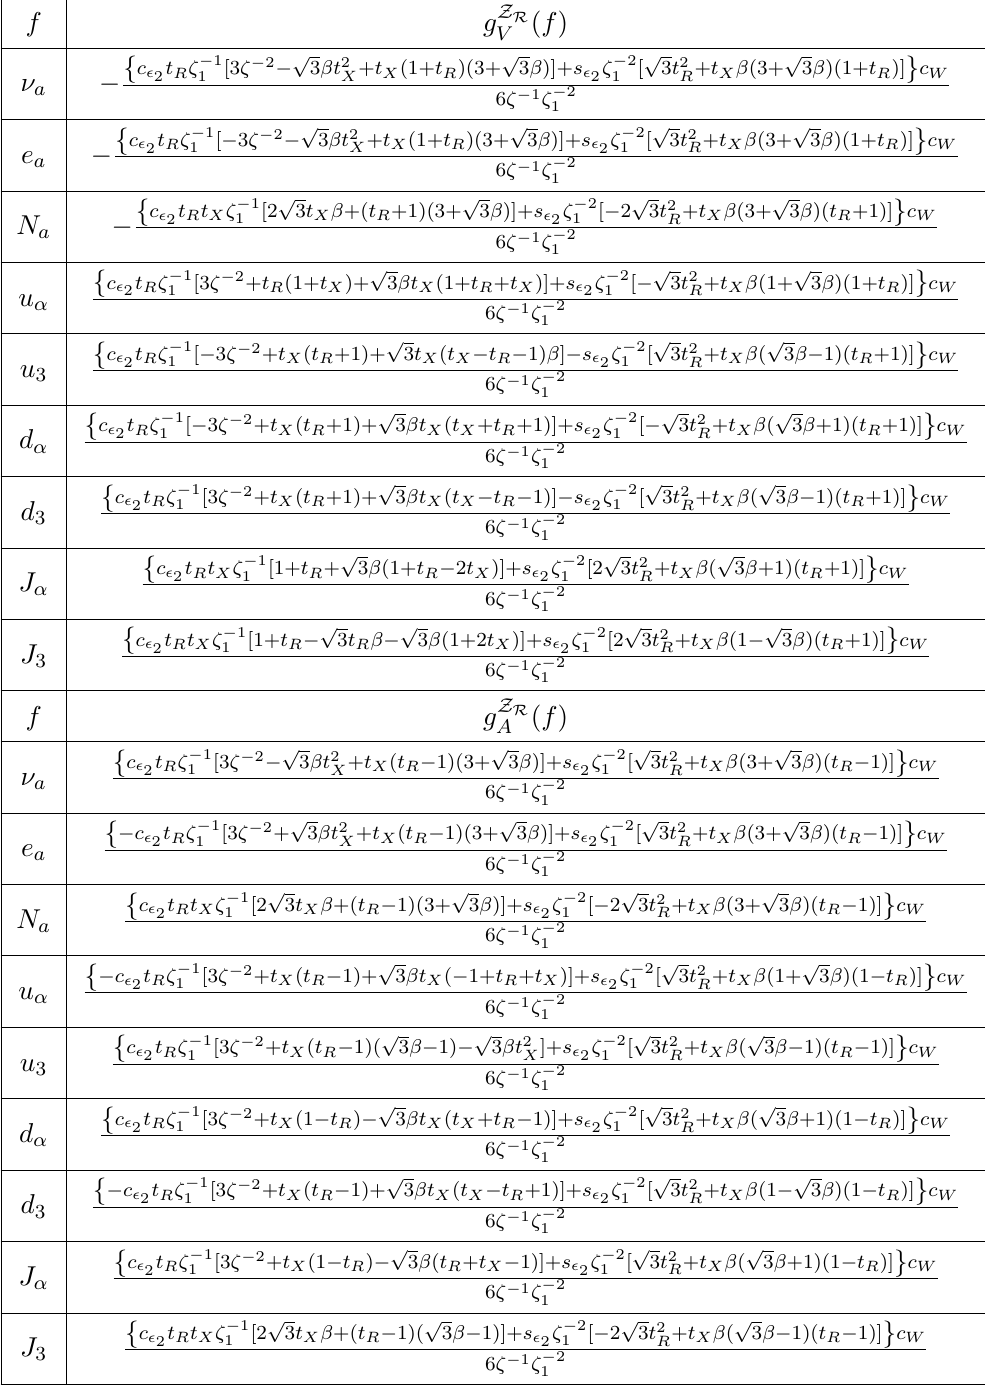
Table 4 . The couplings of Z R with